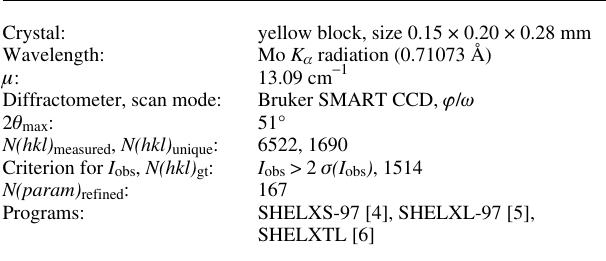
Table 1. Data collection and handling.